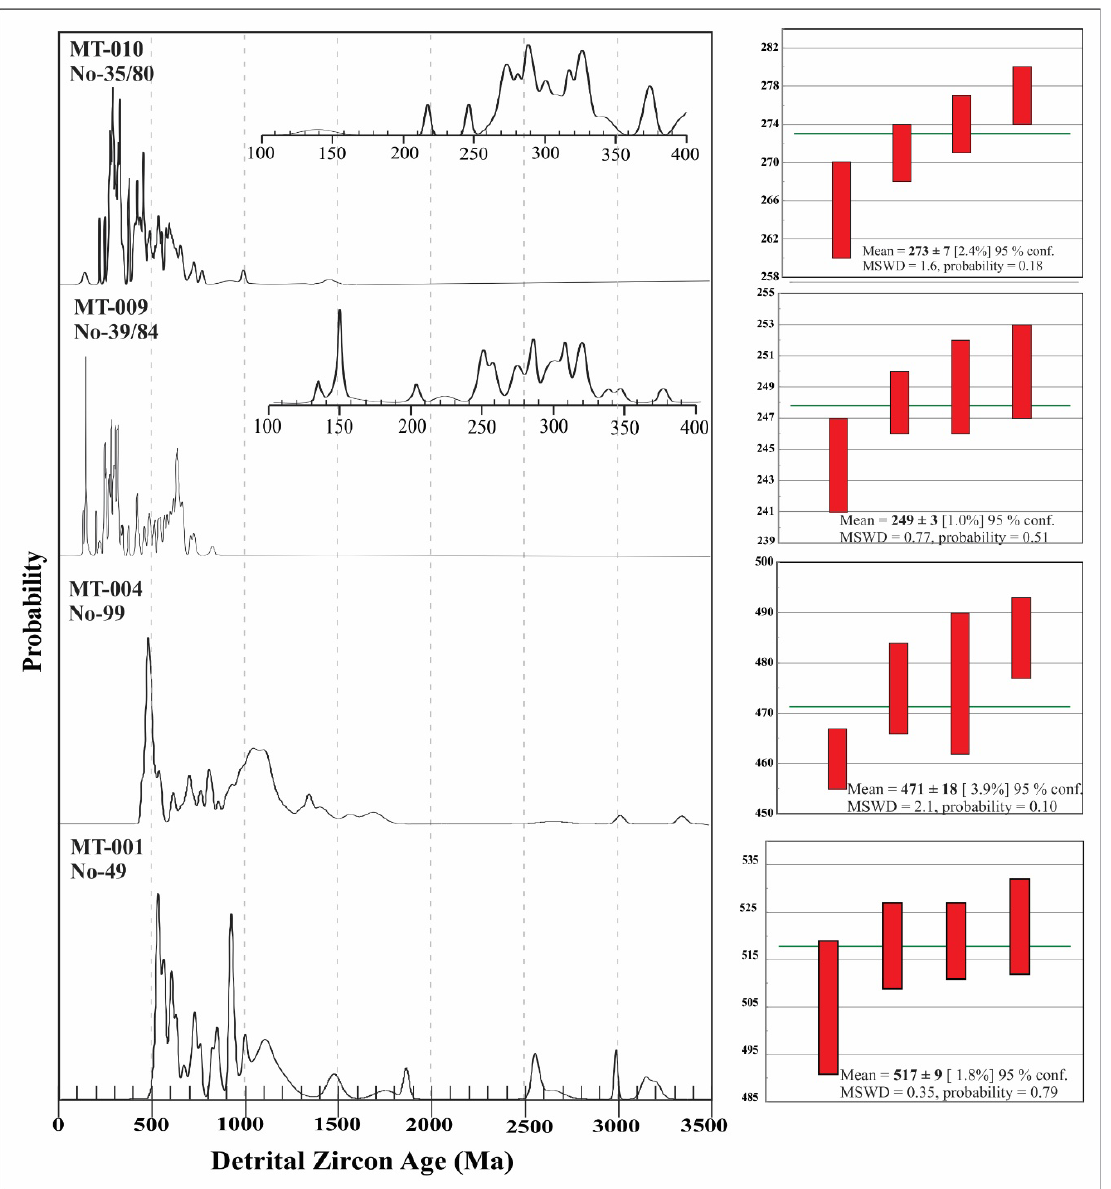
Figure 5. Normalized probability plot of quartzite detrital zircon U-Pb ages from this study, collected from the southernmost section of the Katha-Gangaw range. Samples include MT-001, MT-004, MT-009, and MT-010. No = number of grain analyses in which the denominator indicates the total number, and the numerator indicates the number of grains younger than 400 Ma. The right figure of each sample indicates the maximum depositional age.